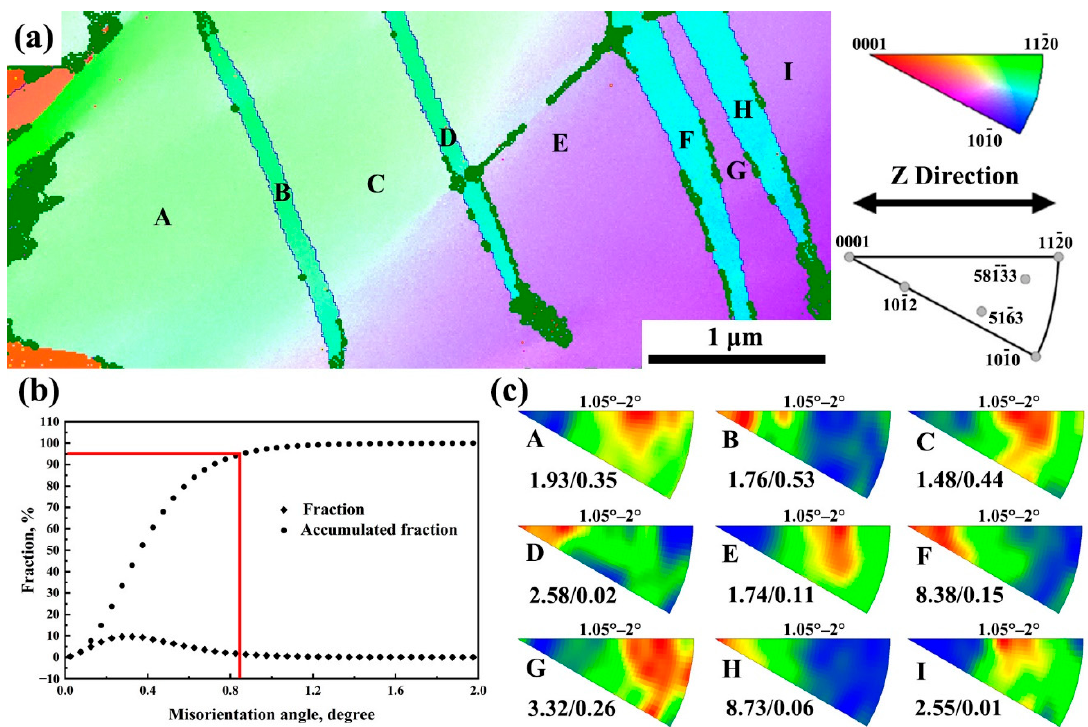
Figure 5. IGMA distribution in a twinning area: ( a ) IPF map of a typical area; ( b ) fraction and accumulated fraction of misorientation angles below 2°; ( c ) IGMA distribution of individual grains and twins in ( a ).